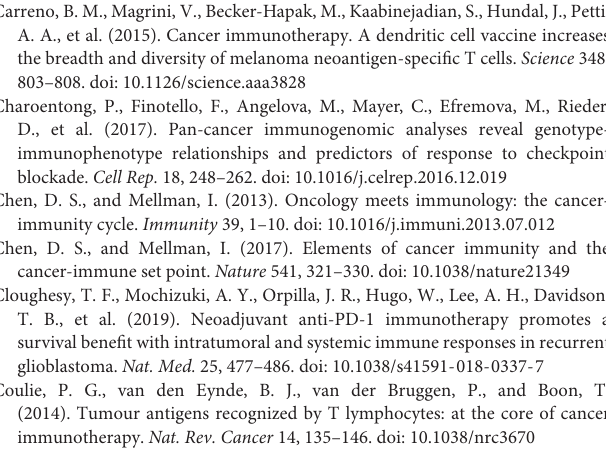
Supplementary Figure 1 | Unsupervised clustering grouping in ccRCC. (A) Unsupervised hierarchical clustering algorithm in ccRCC patients. (B–F) Unsupervised clustering of 182 DEGs in the ccRCC cohort and consensus matrices for k = 2–5. Supplementary Figure 2 | Immune infiltration status and prognosis of different mutated genes in different immune score groups. (A) Immune cell abundance ratios in the two immune scoring cohorts. Each column represents a sample, and each column uses a different color and height to indicate the abundance ratio of immune cells in the sample. (B) The RNA expression levels of HLA genes in samples from the ISL group and ISH group ( p -value, ∗∗∗ < 0.001). (C–V) K-M analysis of genes with higher mutation frequencies in ccRCC samples and different immune score cohorts. Supplementary Figure 3 | Mutations in different immune score groups and possible drug pathways. (A,B) Summary of the mutation information with statistical calculations. The mutation types were classified according to different categories. Among them, missense mutations accounted for the largest proportion, SNPs appeared more frequently than insertions or deletions, and C > T was the most common mutation in SNVs. The top 10 mutated genes in the two cohorts are also displayed. (C,F) The lollipop plot illustrates the differential distribution of variants for VHL and PBRM1. (D,E) The potential gene categories for drug therapy in the two cohorts and the top five genes involved. Supplementary File 1 | The univariate Cox regression analysis results of DEGs with the p -value < 0.01. Supplementary File 2 | The groups of unsupervised cluster analysis. Supplementary File 3 | The correlations of immune cells in the ISL and ISH groups. Supplementary File 4 | The quantitative results of immune infiltrating cells in tissues of ccRCC patients used by